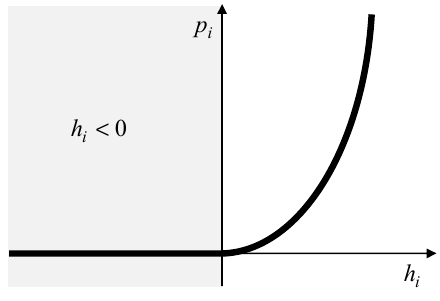
Figure 1. An example of the penalty function (15).